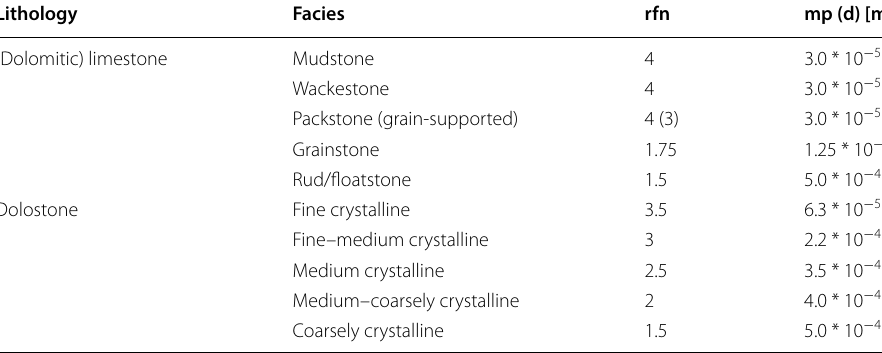
Table 2 Calibration data for permeability models GPPT and Berg model for different facies